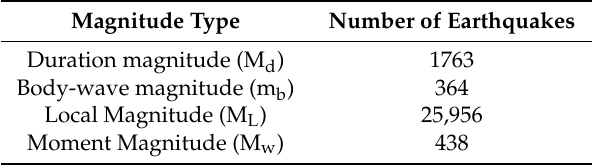
Table 1. Number of earthquakes in different magnitude units during 2006–2017 in Oklahoma.